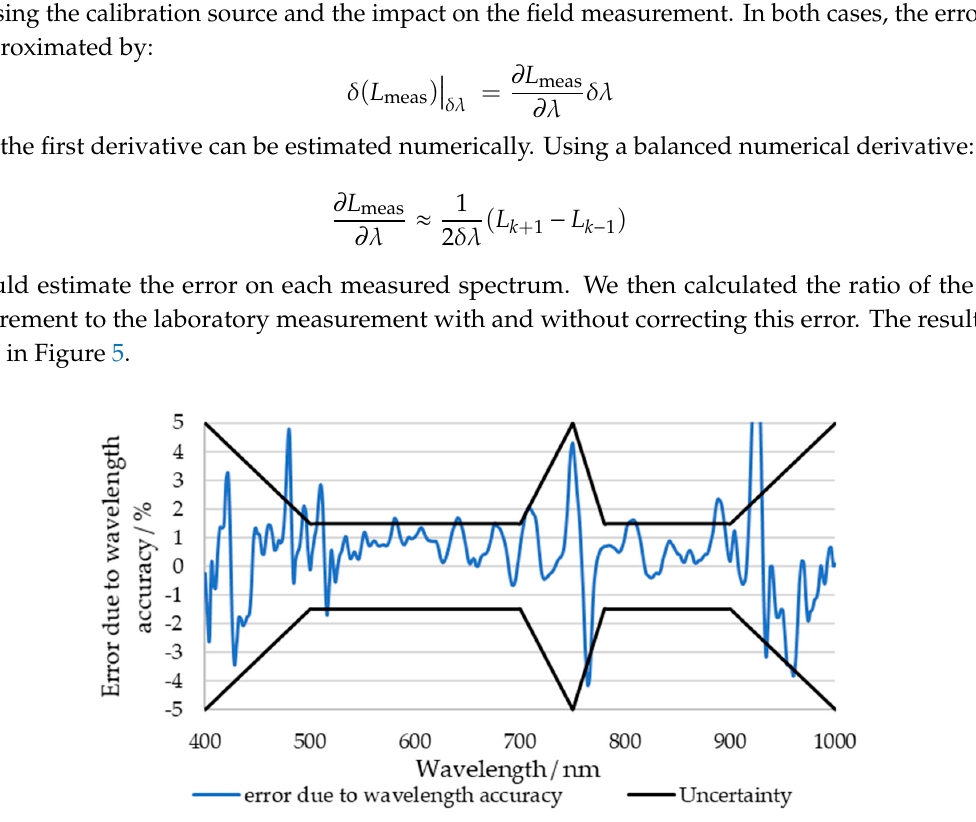
Figure 5. Error in the ratio of the field to laboratory measurement (proxy for error in the true field measurement) due to not correcting for wavelength.